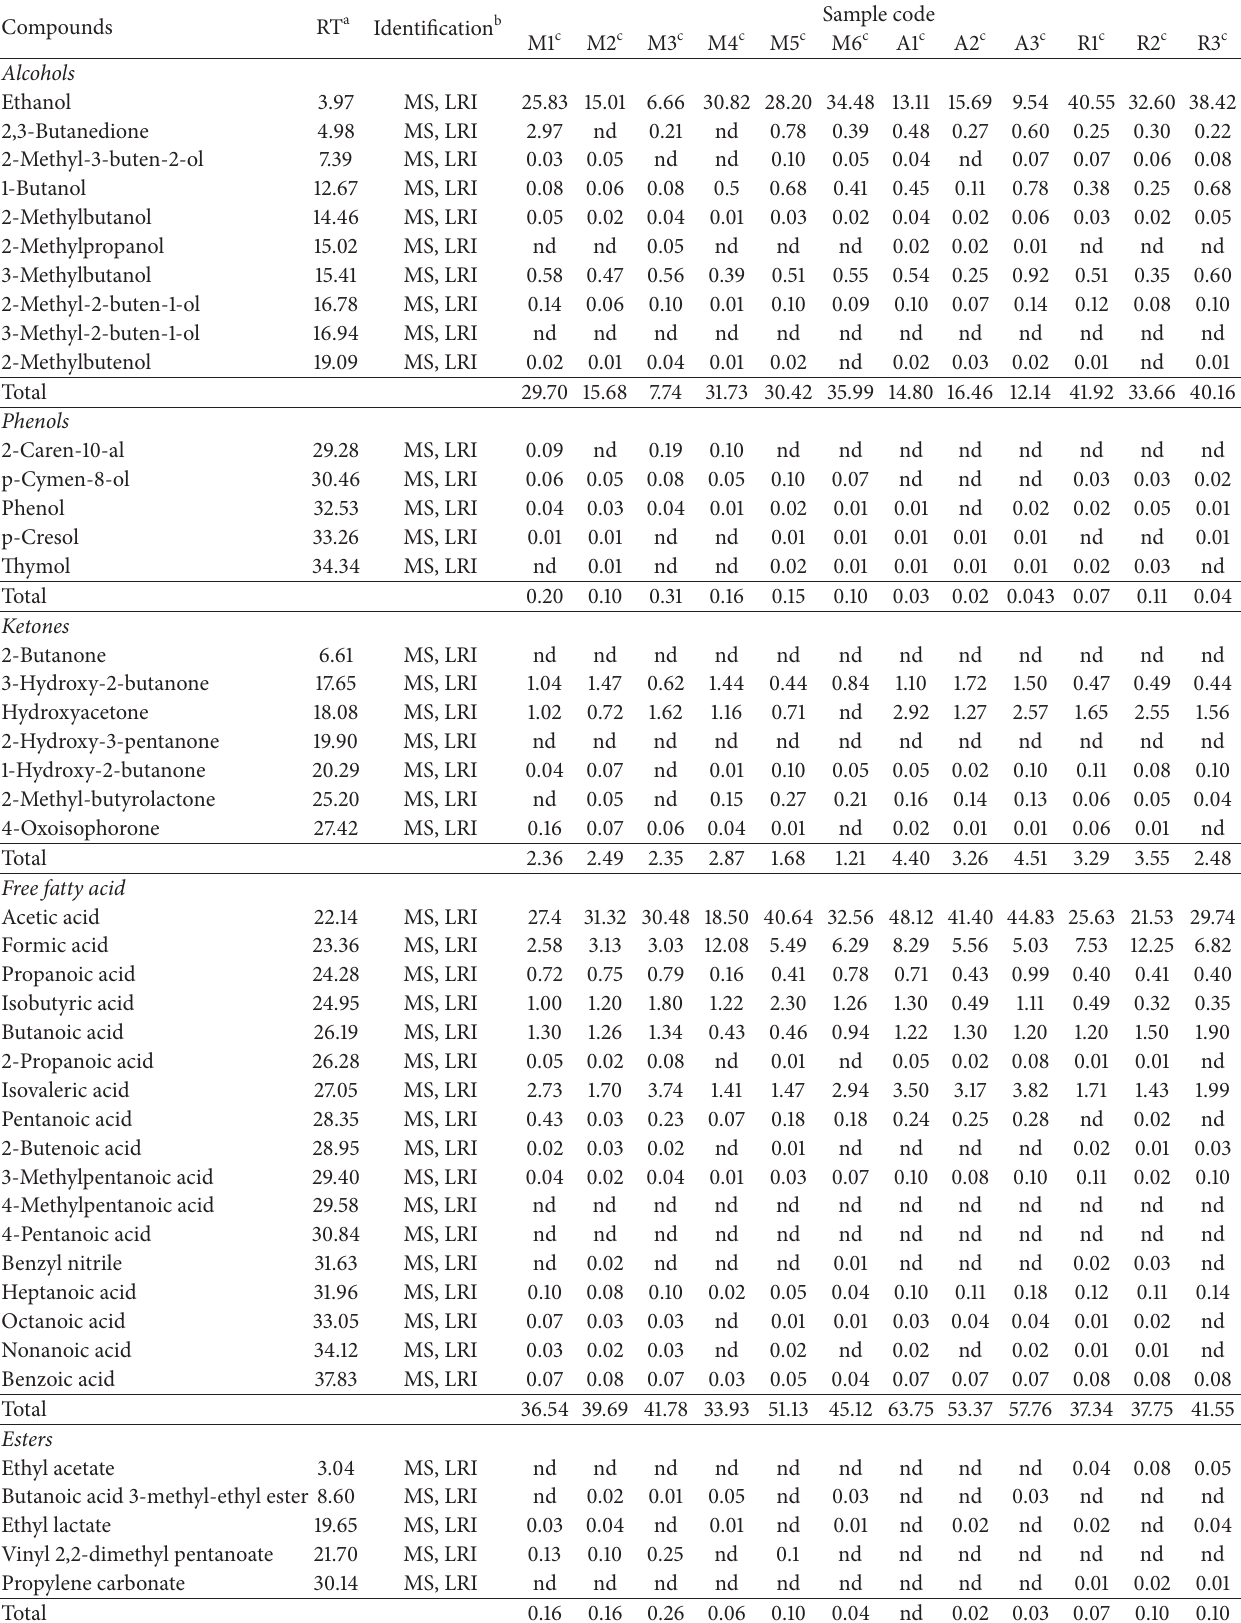
Table5:Volatilecompoundsidentifiedininvestigatedhoneysamplesexpressedaspercentages.M1–M3:multifloralhoneysfromItaly(Teglio- Valtellina); M4–M6: multifloral honeys from Italy (Valtellina); A1–A3: acacia honeys from Italy (Valtellina); R1–R3: rhododendron honeys from Italy